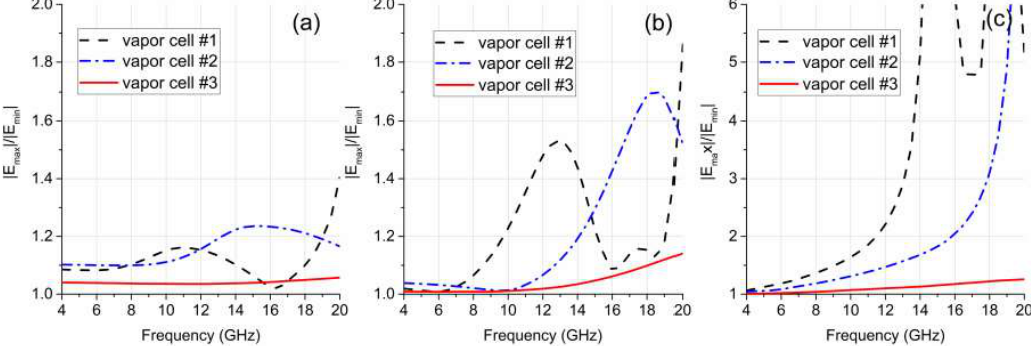
Figure 4. Computed field uniformity of the vapor cells from 4 GHz to 20 GHz, using the ratio of maximum to minimum field strength (| E max |/| E min |) over the calculation range as an indicator. The results of field distribution uniformity in the vapor cell center along the ( a ) x -axis, ( b ) y -axis, and ( c ) z -axis.